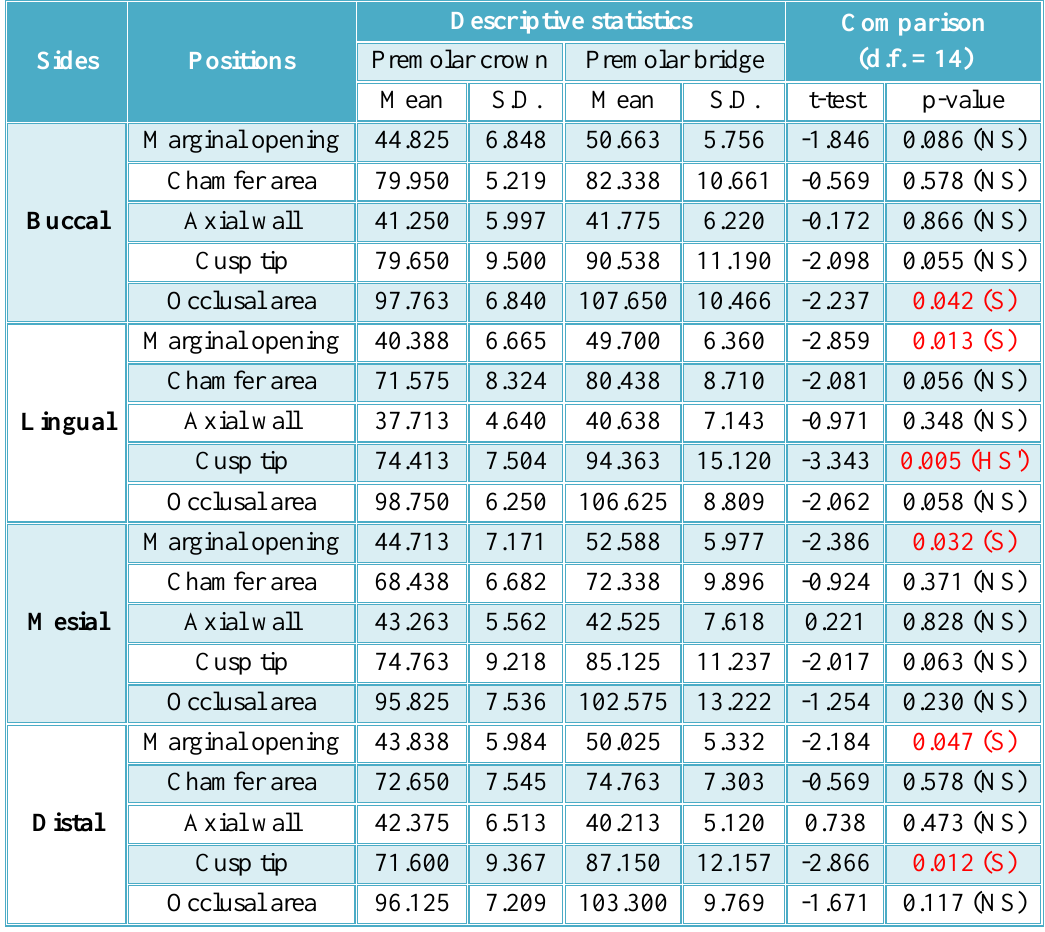
Table (1): Comparing the marginal and internal fitness between Premolar single crown and premolar within the